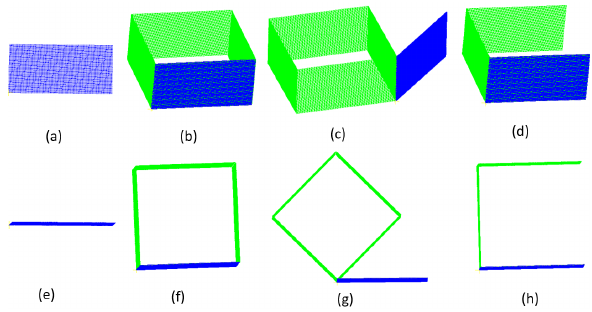
Figure 3: Point cloud C 1 . The leftmost column shows C 1 alone. The remaining 3 columns show the overlapping of C 1 with M 1 , M 2 and M 3 , from left to right.